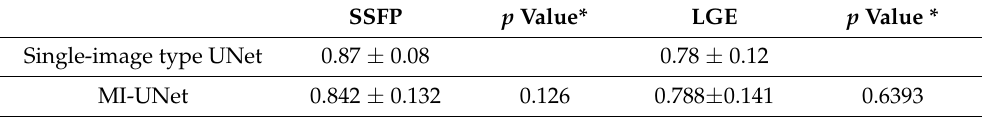
Table 1. Dice Similarity Coefficient for the MI-UNet compared to a single-image type UNet. SSFP p Value* LGE p Value * Single-image type UNet 0.87 ± 0.08 0.78 ± 0.12 MI-UNet 0.842 ± 0.132 0.126 0.788 ± 0.141